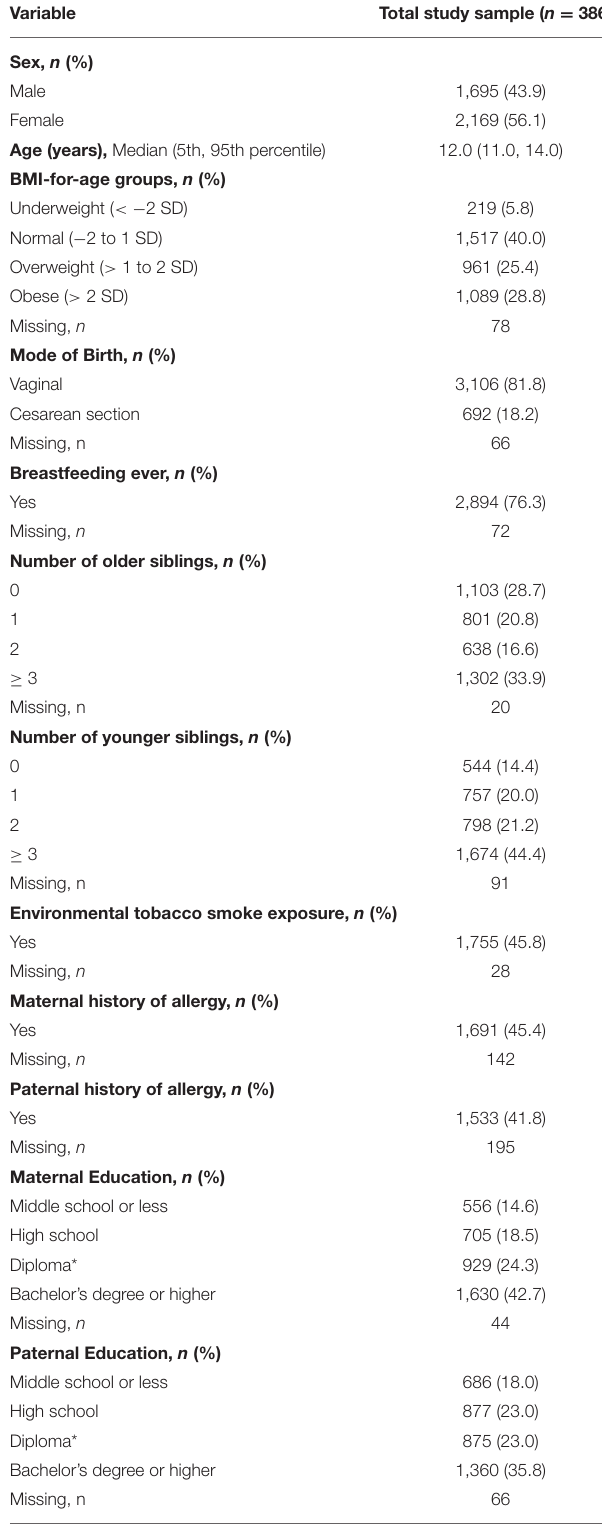
TABLE 1 | Characteristics of the total study